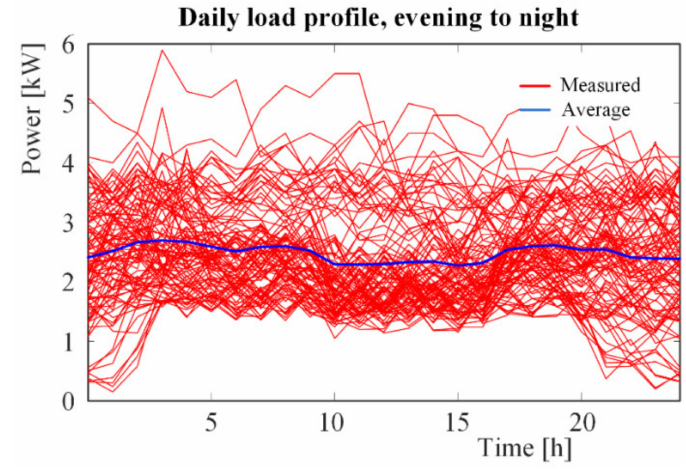
Figure 9. The evening-night peak consumption pattern.